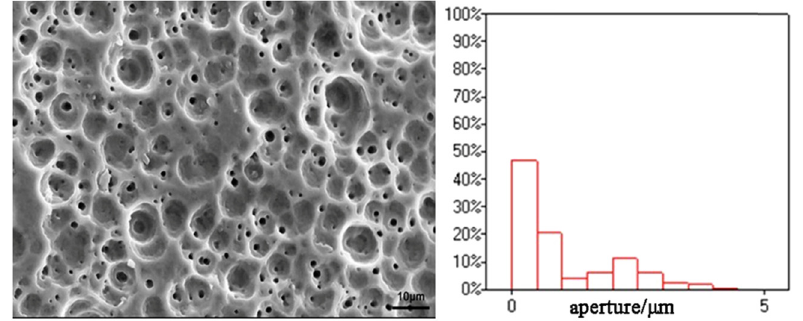
Figure 12: Histogram of pore size distribution after T liquid treatment for 30 min.